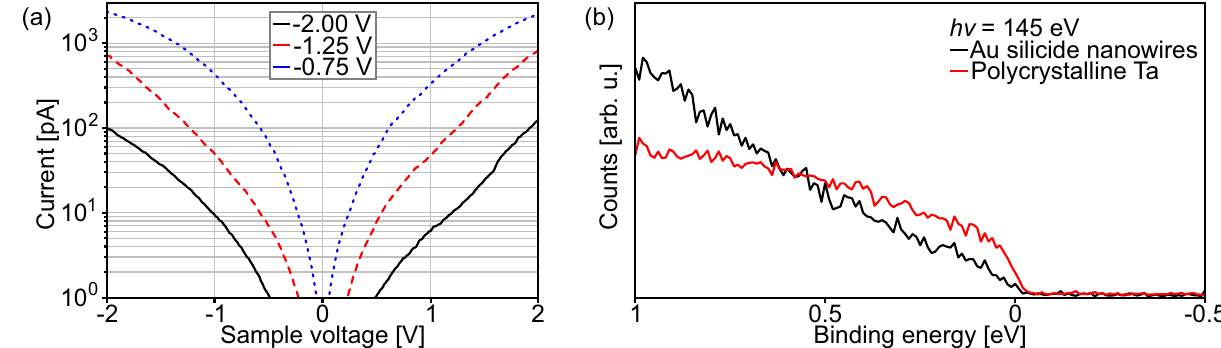
Figure 4. ( a ) STS spectra taken on Au silicide nanowires. Between the spectra the stabilising sample voltage was changed in the way indicated in the figure legend. The stabilising current was always I spectra near the Fermi level for an Au silicide nanowire sample and polycrystalline Ta covered with a small amount of Au as